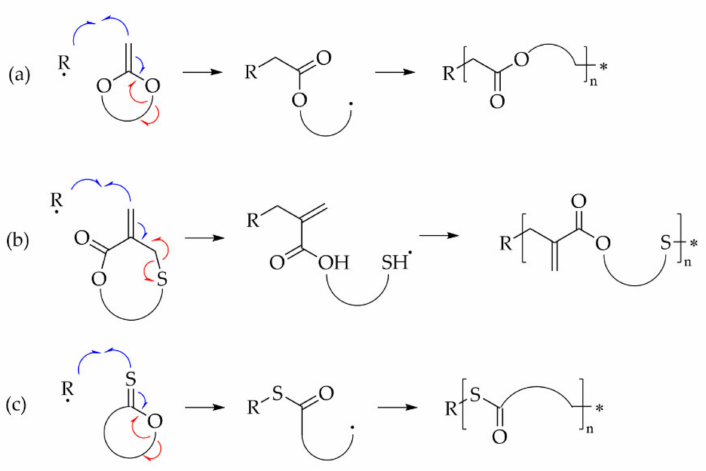
Figure 8. Radical ring-opening polymerization from ( a ) Cyclic Ketene Acetal, ( b ) Allyl sulfide lactones and ( c ) Thionolactones.